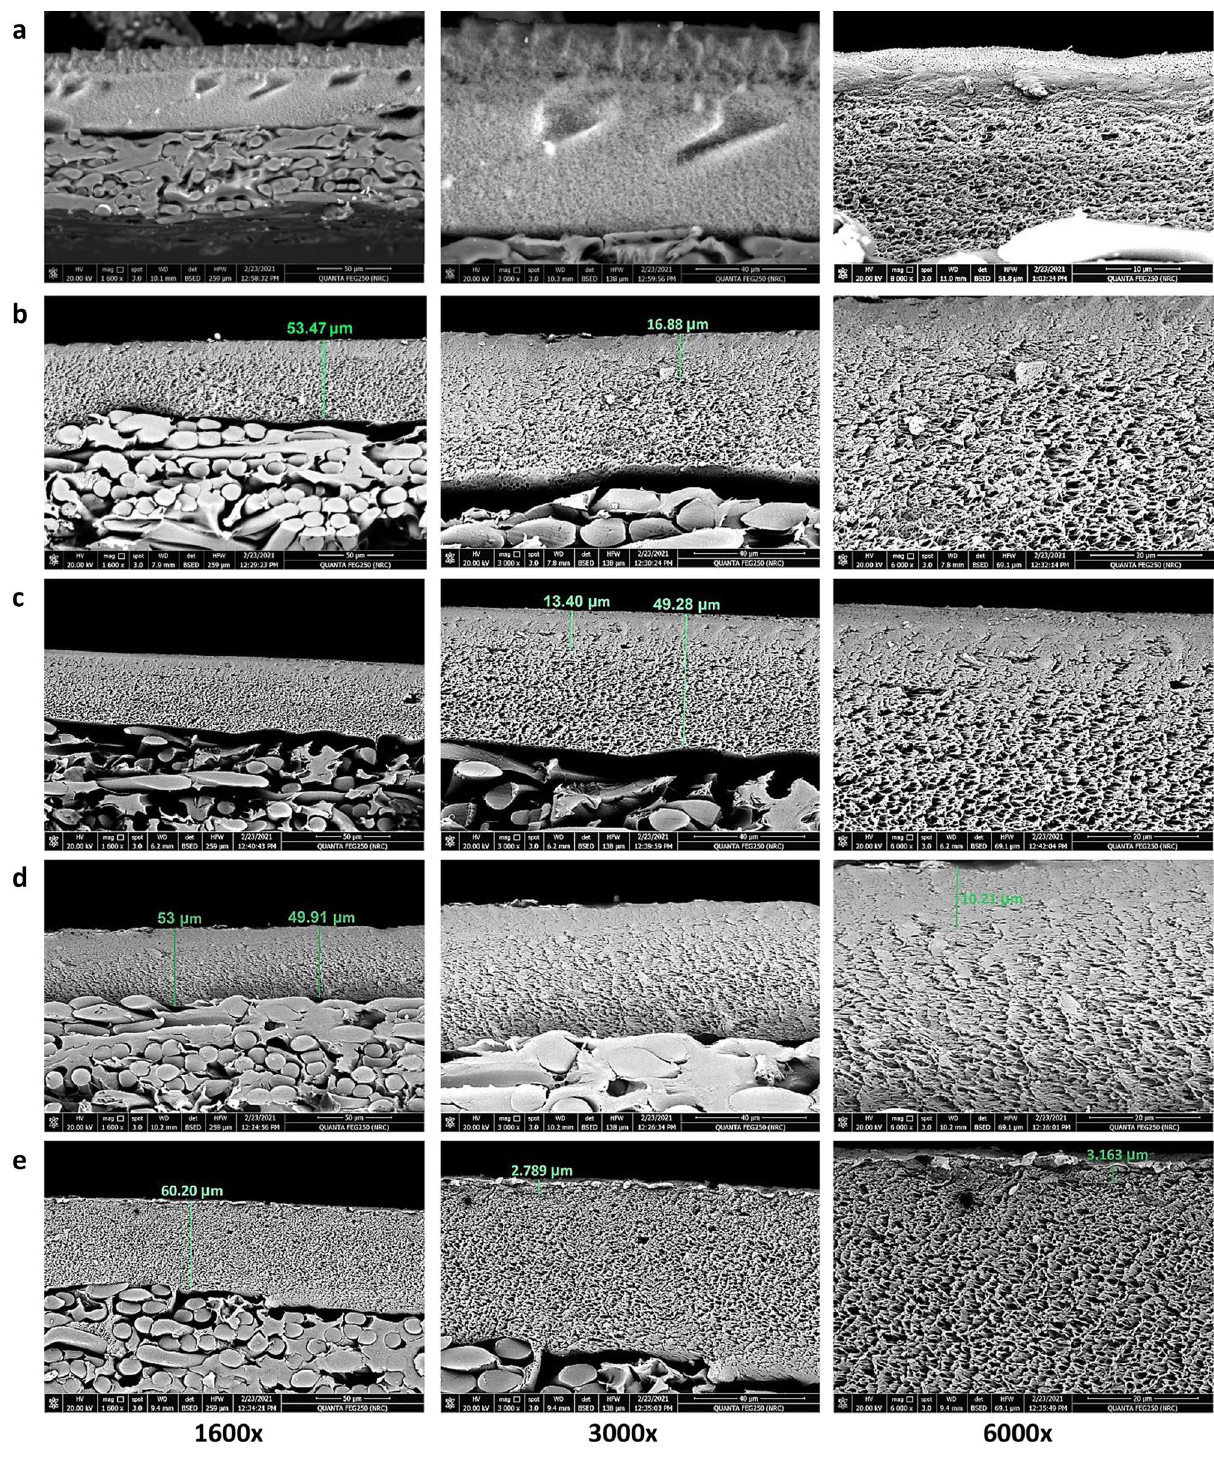
Figure 10. SEM cross-section micrographs of ( a ) TFC membrane, and ( b – e ) TFN-Al 2 O 3 membranes with varied fractions of mesoporous